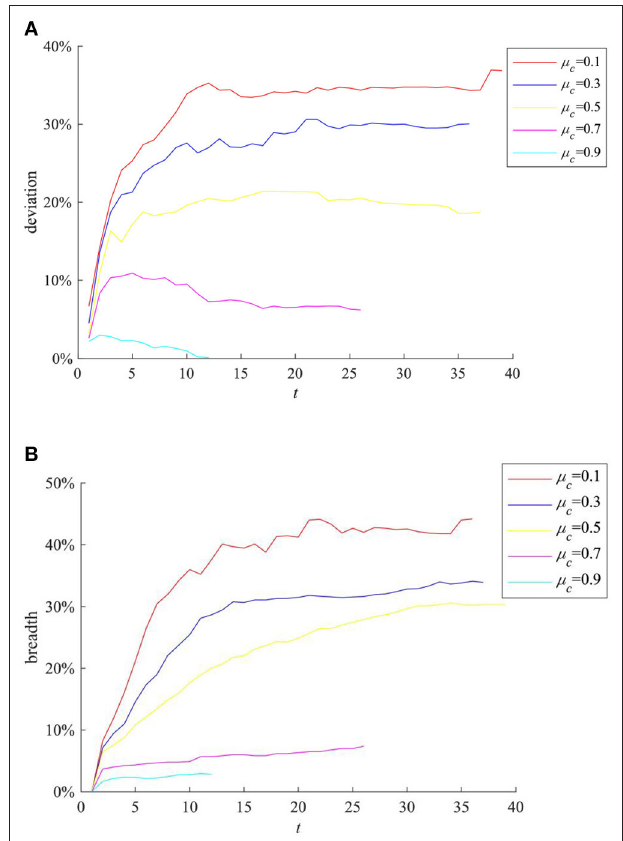
FIGURE 8 | The impact of µ c on rumor evolution process. (A) Information content deviation. (B) Rumor diffusion range.